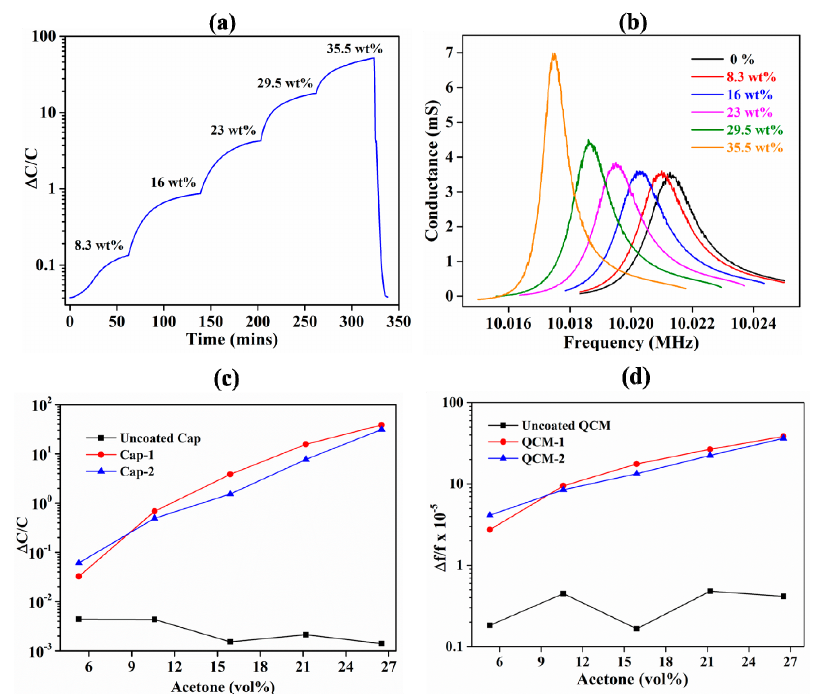
Figure 5. Response of the ZIF-8-coated and uncoated sensors to acetone gas. ( a ) This shows the typical response of the ZIF-8-coated capacitive sensors. ( b ) This shows the typical response of the ZIF-8-coated QCM-based sensors. ( c ) This shows the sensitivity of the two ZIF-8-coated (Cap-1 and Cap-2) and uncoated IDE capacitive sensors. ( d ) This shows the sensitivity of the ZIF-8 coated (QCM-1 and QCM-2) and uncoated QCM-based sensors.